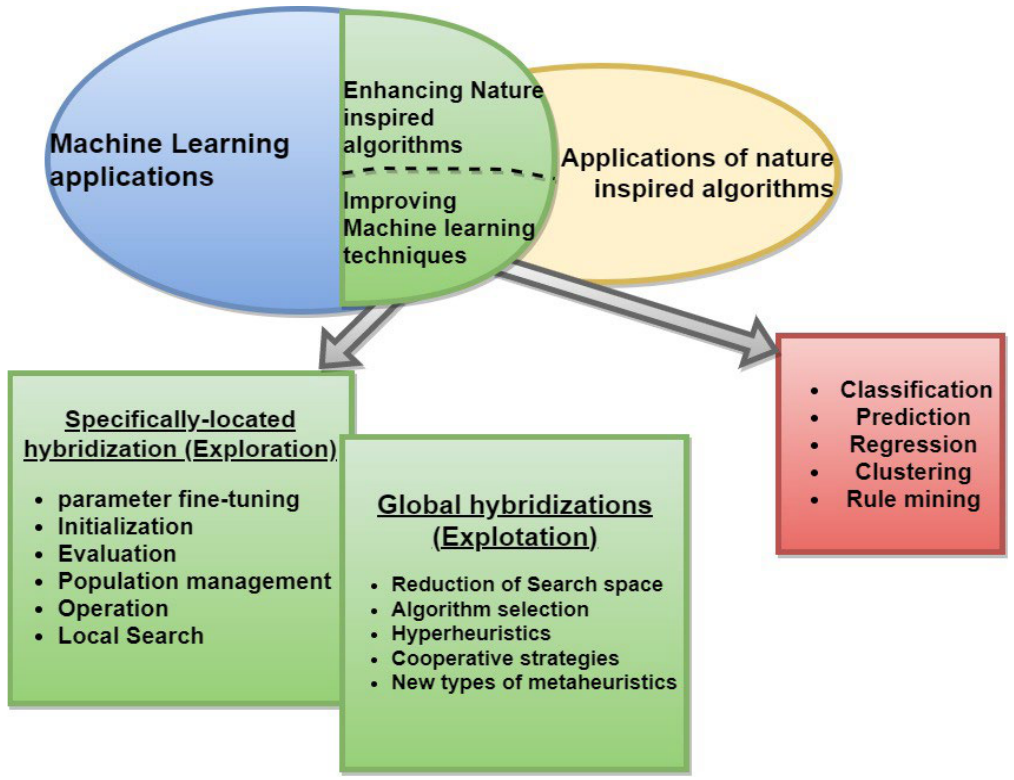
Figure 12. Hybridization of nature-inspired algorithms with a ML model to optimize cancer classifi- cation and prediction